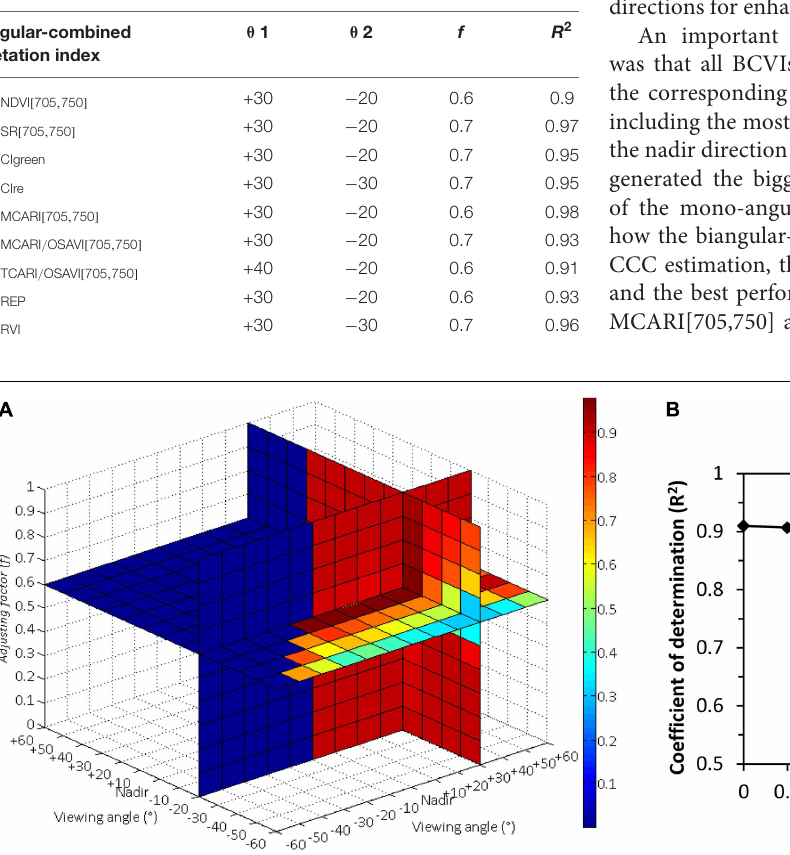
TABLE 5 | The optimal two-angle combination ( θ 1 and θ 2), the adjusting factor f constructed in each best performing BCVI, and the corresponding maximum R 2 for canopy chlorophyll content estimation using model-simulated data.